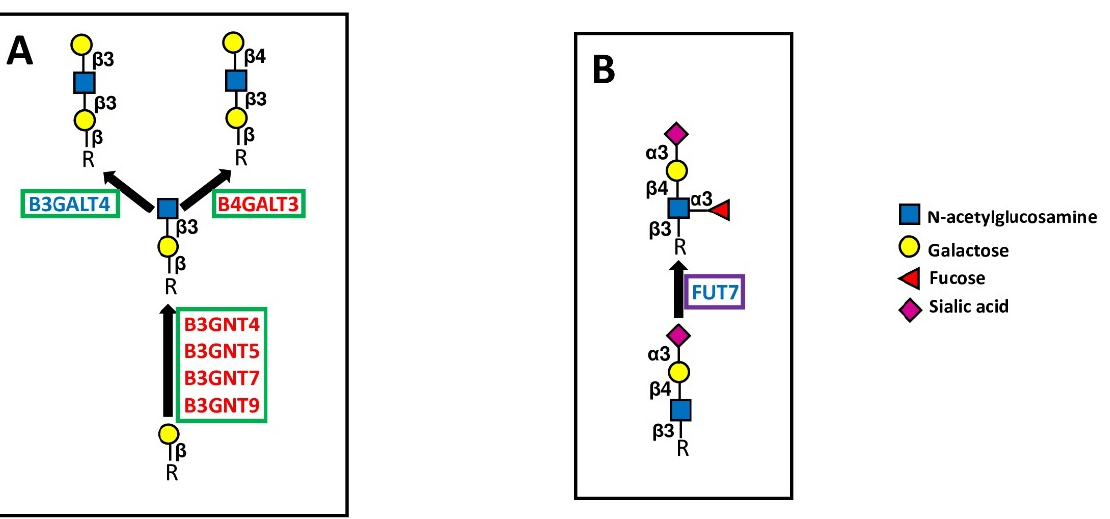
Figure 6. Extension and capping of chains. ( A ) shows the elongation of polylactosaminic chains. ( B ) shows the structure and biosynthesis of the sialyl Lewis x antigen, catalyzed by FUT7, as an example of chain capping. Elongating enzymes are boxed in green, and capping enzymes are boxed in violet.